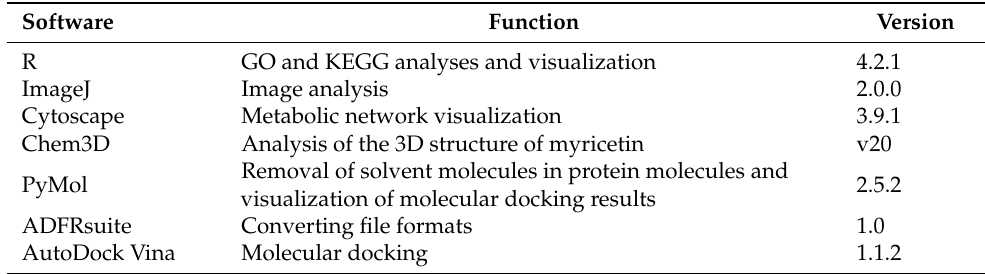
Table 2. Software used in the